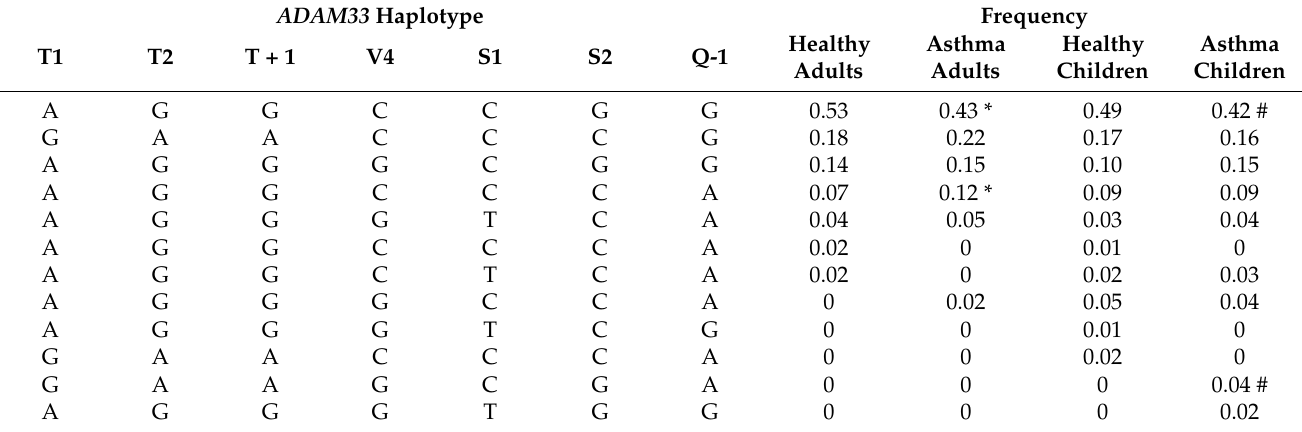
Table 7. The frequency of the ADAM33 haplotype among adult and children asthma and rhinitis patients.